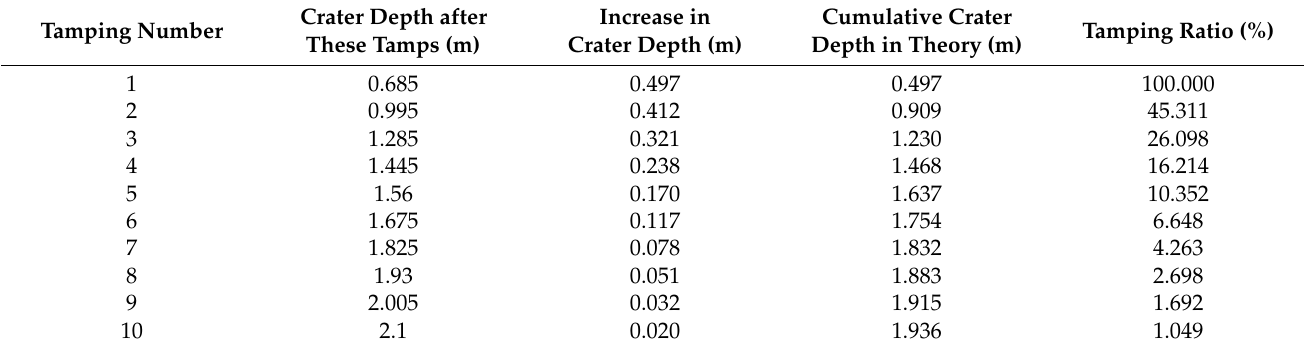
Table 1. The crater depth of ten tamping times with the group of 47.94 t × 20.86